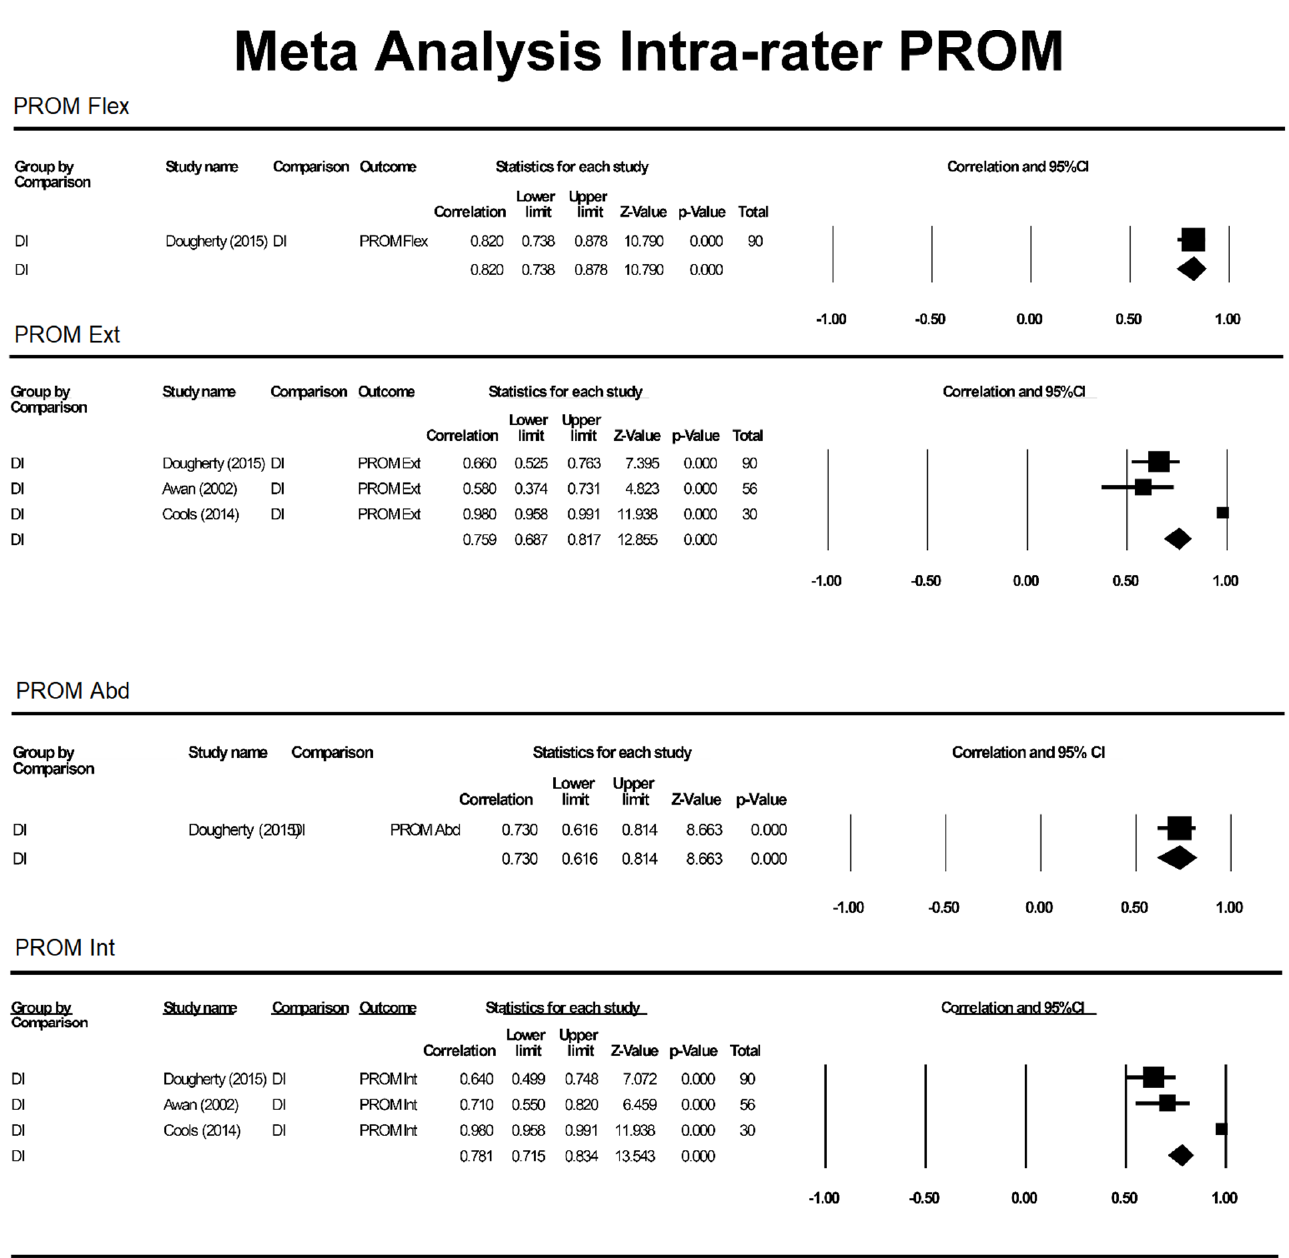
Figure 2. Meta-analysis for intra-rater AROM. DG = digital goniometer, DI = digital inclinometer, IS = inertial sensor, K = Kinect, SP = smartphone, Abd = abduction, AROM = active range of motion, Int = internal rotation, Ext = external rotation.